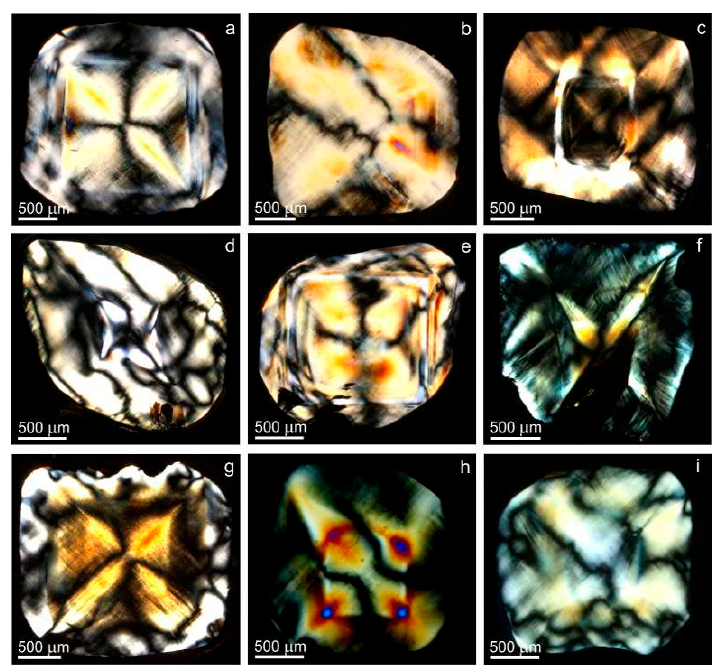
Figure 5. Anomalous birefringence patterns of double-polished plates of yellow cuboid diamonds from the Northeastern Siberian platform (photos taken between crossed polarizers) ( a —MP-30; b —MP-43; c —MP-56; d —MP-60; e —MP-71; f —MP-83; g —MP-87; h —MP-98; i —MP-108).